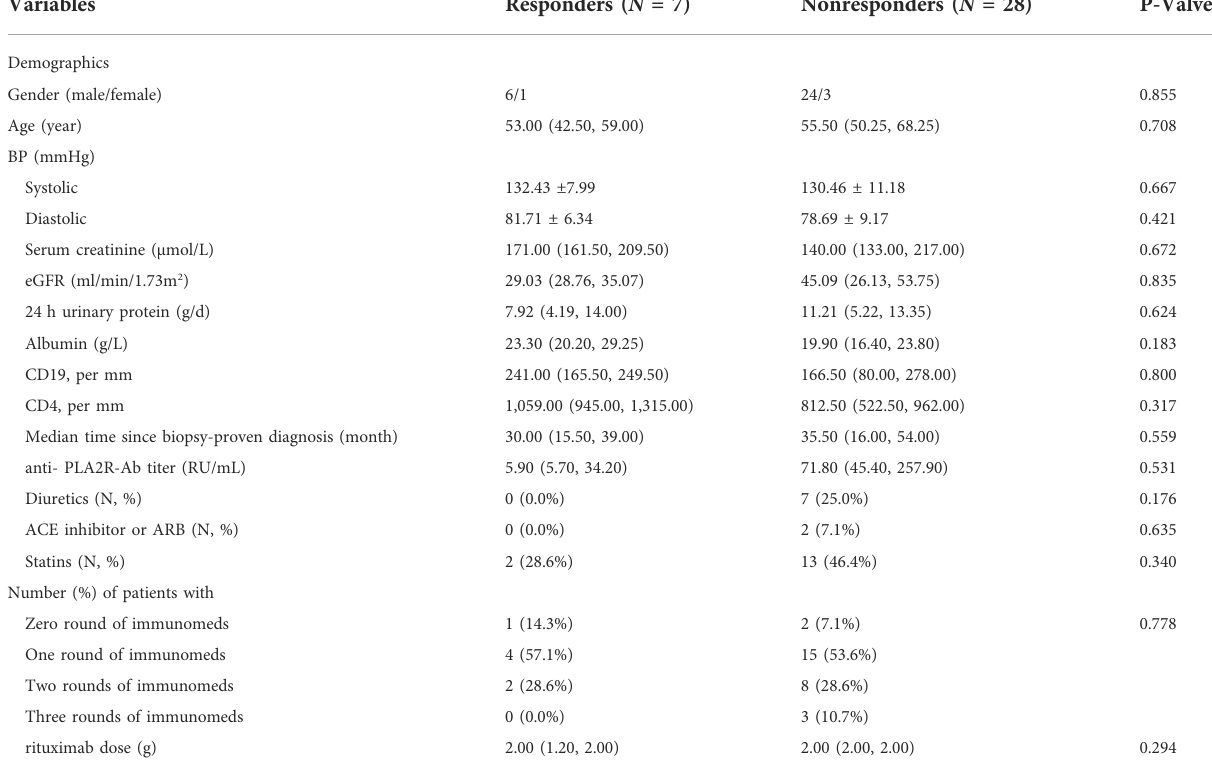
TABLE 3 Comparison between responders and nonresponders at rituximab